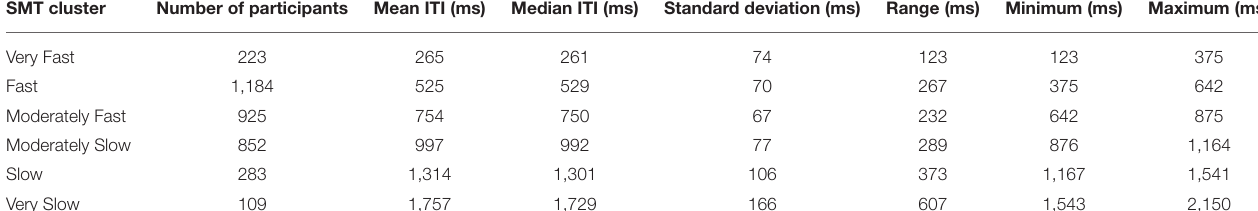
TABLE 3 | Descriptive statistics of each SMT cluster.